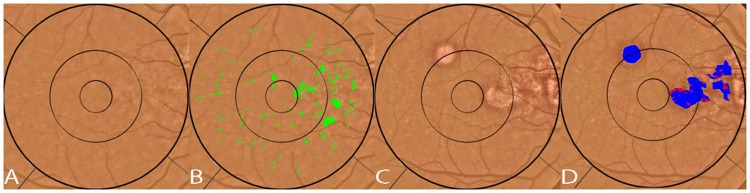
Drusen regression and its correlation with new geographic atrophy (GA).A: Color photo, right eye, Visit 1 (V1). B: V1 photo with soft drusen segmented in green, total pixel area 2,452. GA is not present. C: Color photo, right eye, Visit 5 (V5), showing new GA, D: V5 photo with GAs segmented in blue, total pixel area 4,161. Drusen from V1 that were absorbed in the GA are overlaid and segmented in red, total pixel area 381, or 9% of geographic atrophy total area. Compared to the original drusen area present in V1 of 2,452 pixels, the 381 drusen pixels converting to GA in V5 represent 16% of the original drusen area.